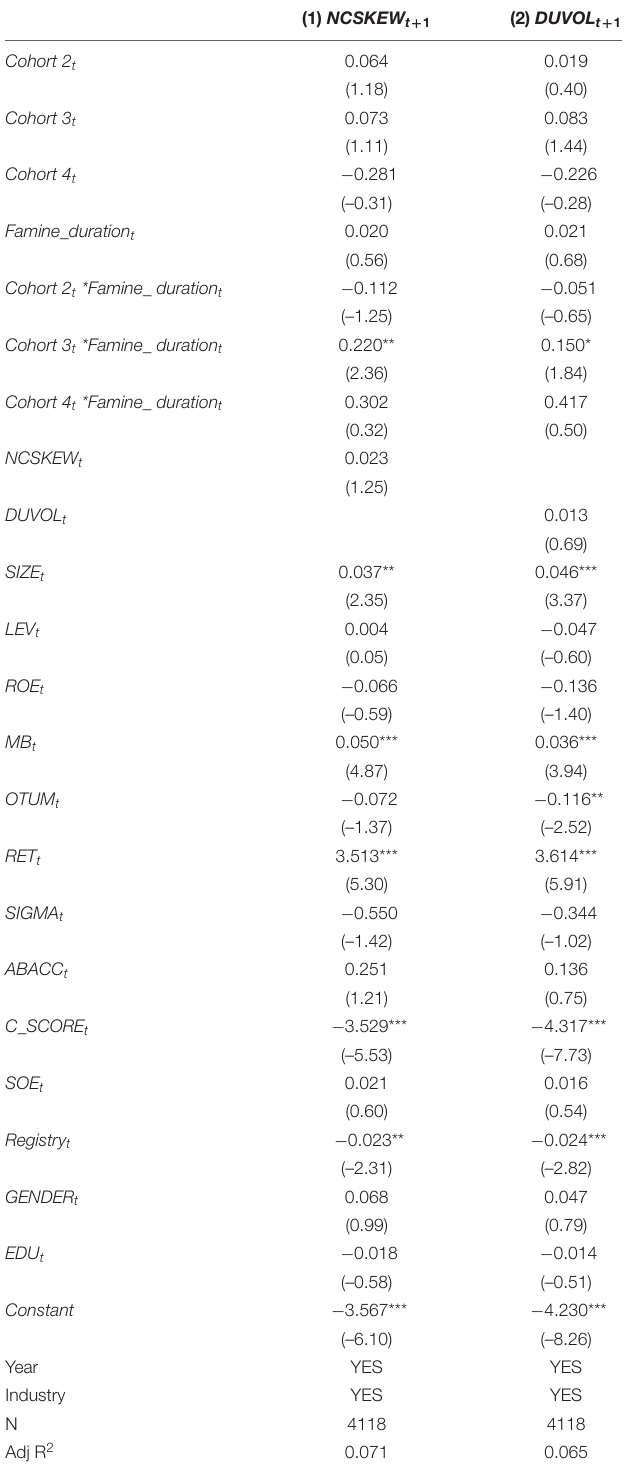
TABLE 8 | Difference-in-difference estimation by using different cohorts and famine